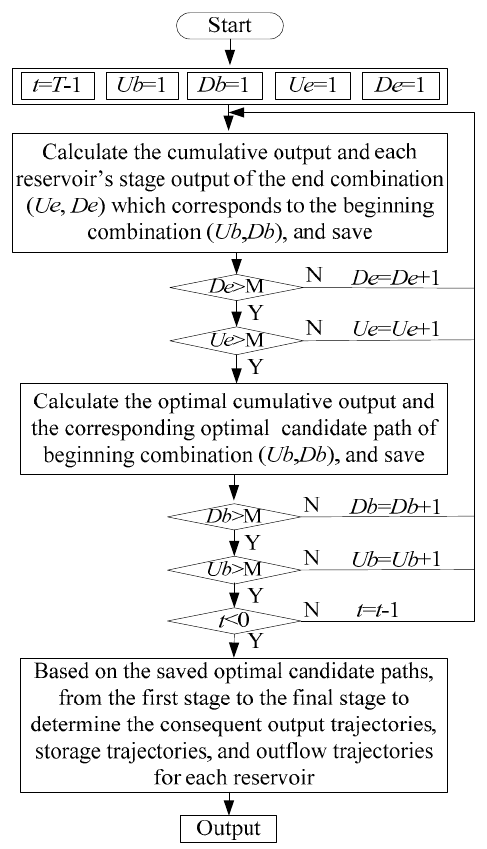
Figure 1. The flowchart of multidimensional dynamic programming in solving the cascade reservoirs operation optimization problem.